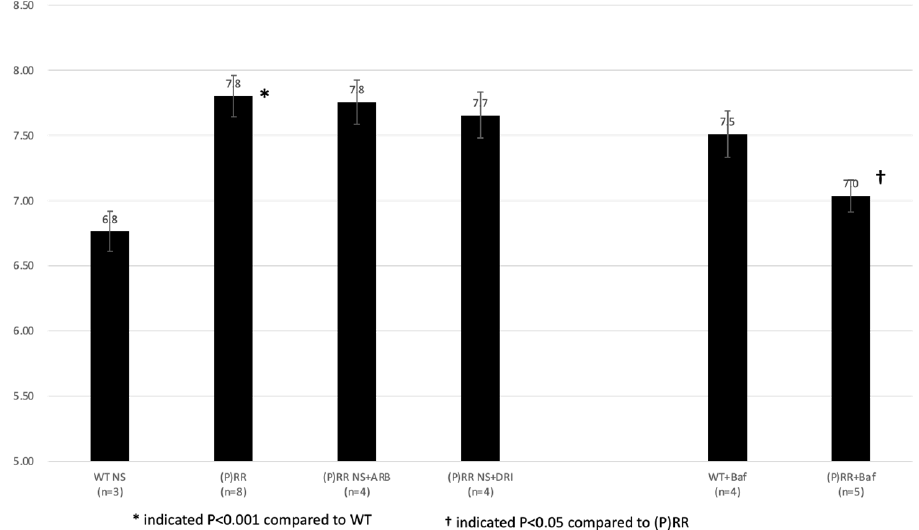
Figure 8. Average urine pH of animals is shown. Data were analyzed using one-way ANOVA between (P)RR mice and t -test between WT and (P)RR mice.